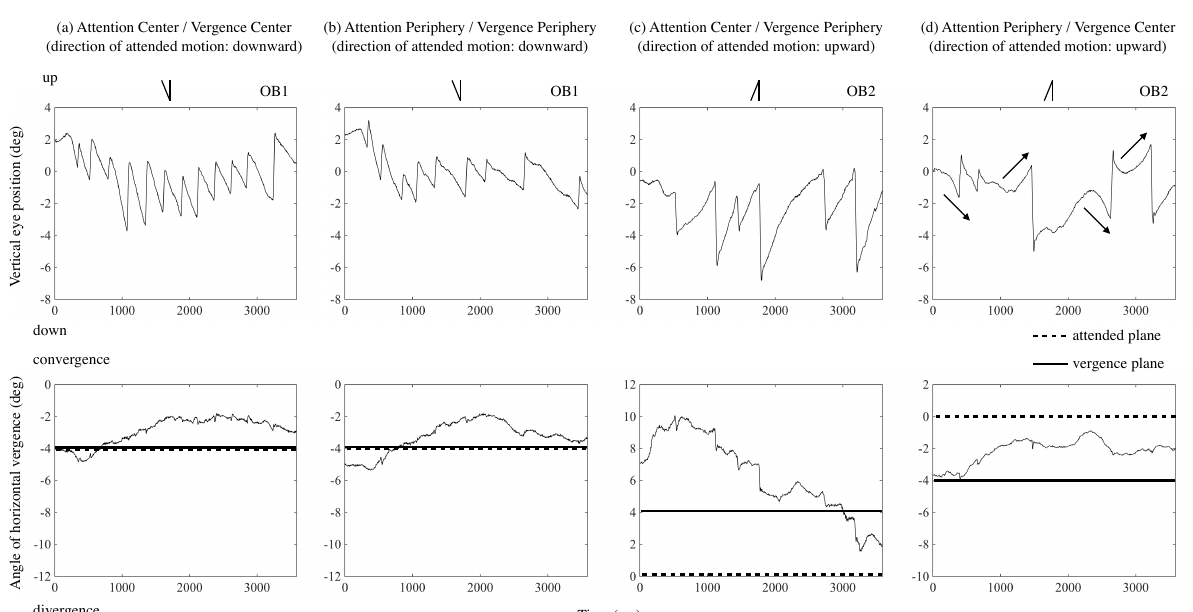
Figure 5. Trace of eye position in a trial for two observers (OB1 and OB2): The upper four panels depict results of vertical eye position. The lower four panels depict results of horizontal vergence. The line drawing inserted above each panel presents a schematic represen- tation of OKN corresponding to the attended motion in the condition. Horizontal lines in the lower panel show the disparity of the plane to which vergence was instructed to direct, and dotted lines show that to which attention was instructed to